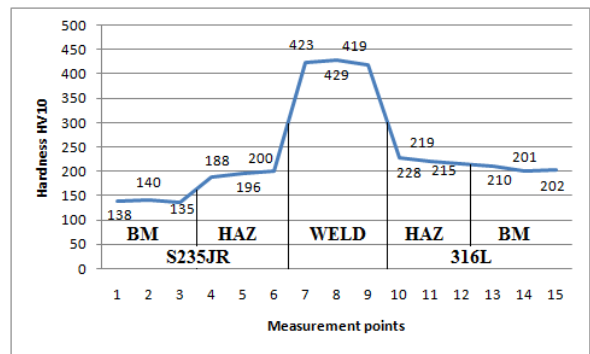
Figure 11: Hardness value in measured test points